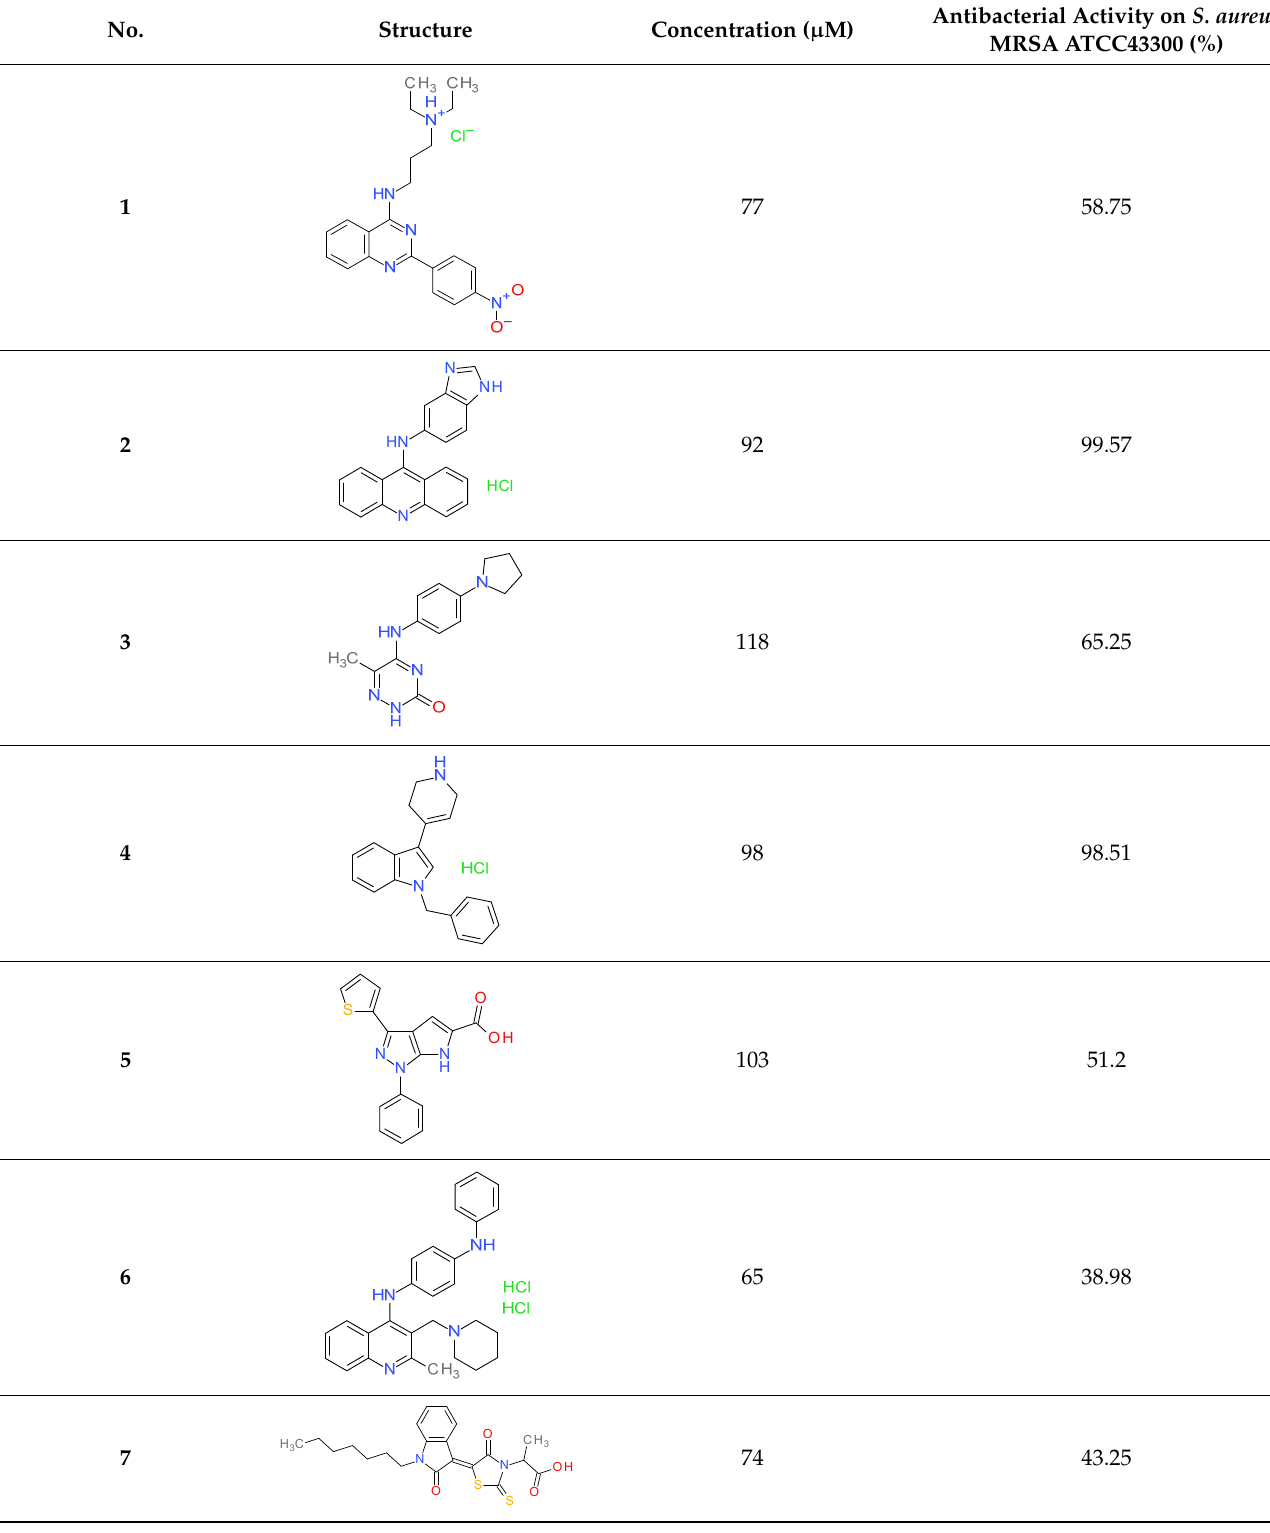
Table 1. Structures and antibacterial activity (percentage growth inhibition) against S. aureus MRSA ATCC43300 for compounds 1–10 at 32 mg/L.